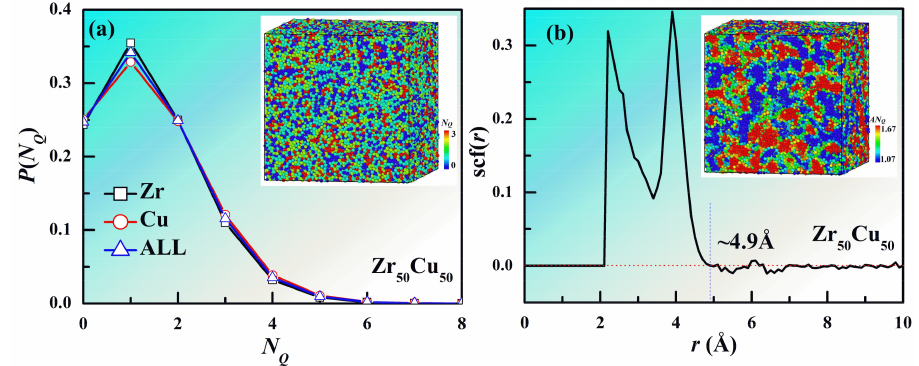
Figure 1. Quantitative and spatial distribution of N Q in Zr 50 Cu 50 MG at 300 K. ( a ) Quantitative distribution. Inset is a configuration with atoms colored by different N Q . ( b ) Spatial correlation function (scf( r )). The spatial correlation length for N Q is about 4.9 Å. we calculated AN Q for each atom as the average N Q value of itself and its neighboring atoms with a distance less than 4.9 Å. Inset is the same configuration in ( a ) but with atoms colored by different AN Q